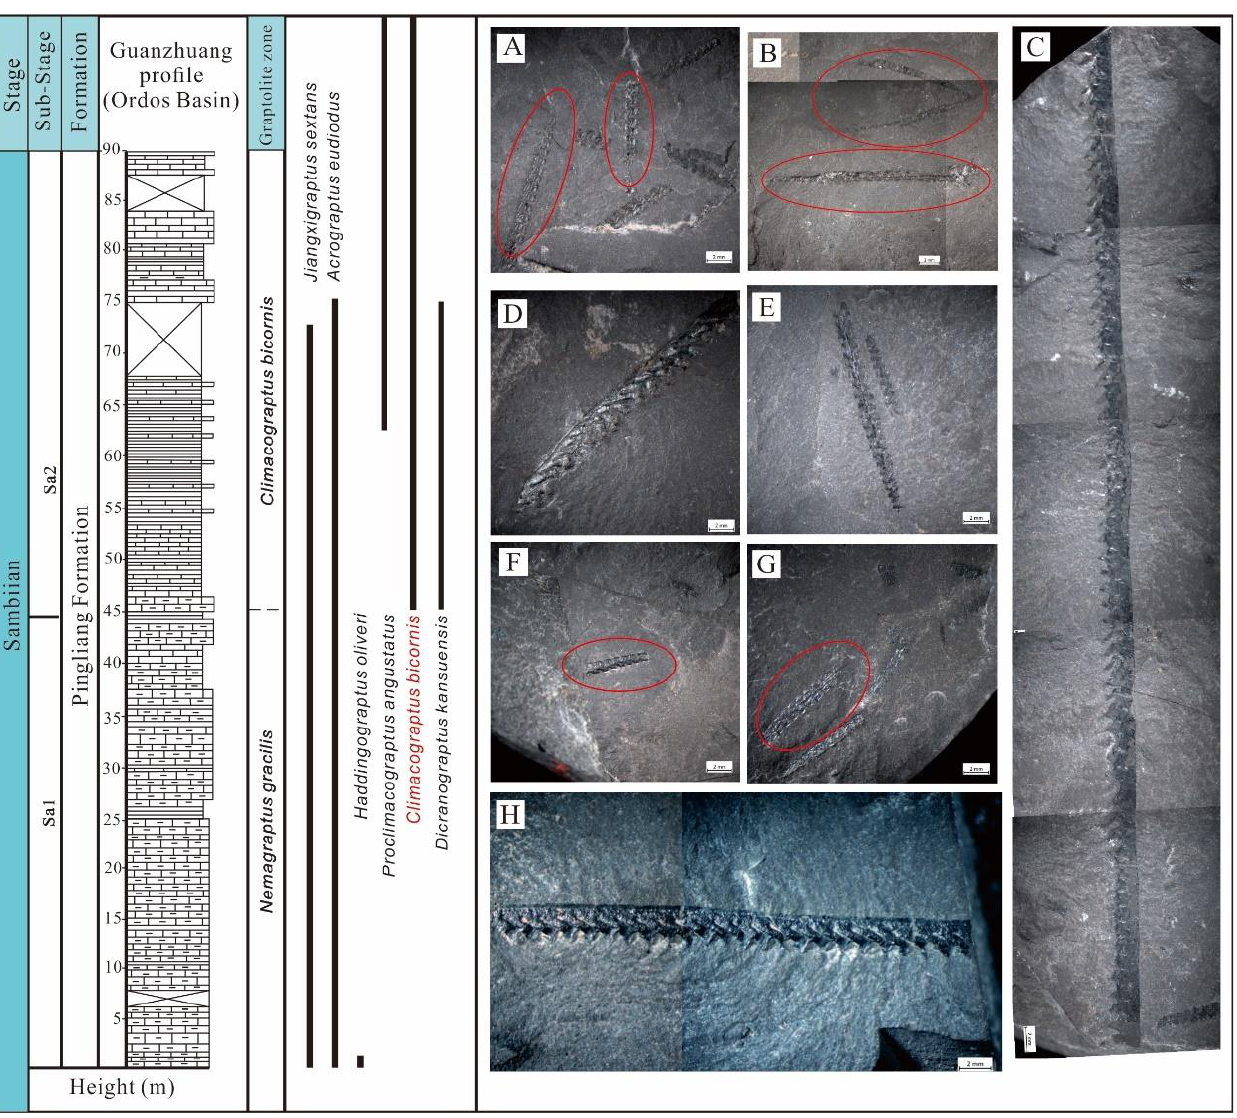
Figure 2. Graptolite extension map and characteristic photos in the study area (The scale bar is 2 mm.). ( A ) 3871.20 m, Climacograptus bicornis ; ( B ) 3868.93 m, Dicranograptus kansuensis , Proclimacograptus angustatus ; ( C ) 3865.19 m, Acrograptus eudiodus ; ( D ) 3865.19 m, Jiangxigraptus sextan ; ( E ) 3865.19 m, Climacograptus bicornis ; ( F ) 3871.20 m, Haddingograptus oliveri ; ( G ) 3865.19 m, Climacograptus bicornis ; ( H ) 3865.19 m, Acrograptus eudiodus .